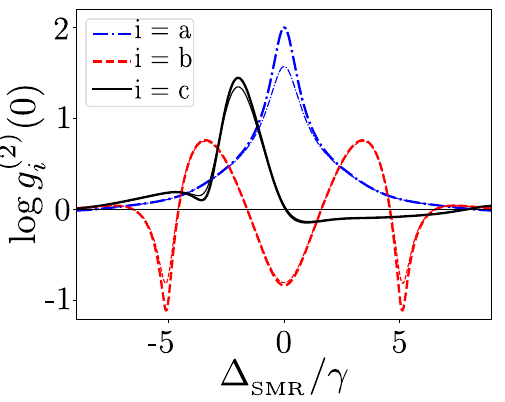
( 2 ) ( 0 ) versus the frequency detuning (cid:31) Figure 12. Correlation functions log g i ω m ω q γ 1560 MHz (so also (cid:31) a system for the resonant case with ω SMR = = = × curves in each mode are obtained using the master equation in Eq. (12) and the thick curves are obtained from the non-Hermitian Hamiltonian method using Eqs. (22) and (23). Parameters are set in Eq. (29) except κ b g 4.5 γ and κ a 6 γ . = = =